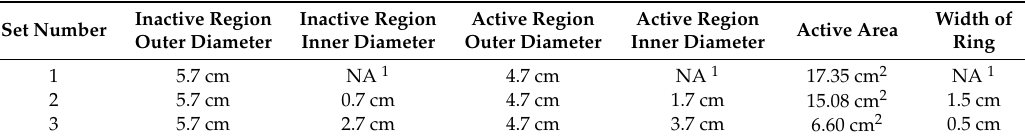
Table 1. Sample Dimensions [23,24].